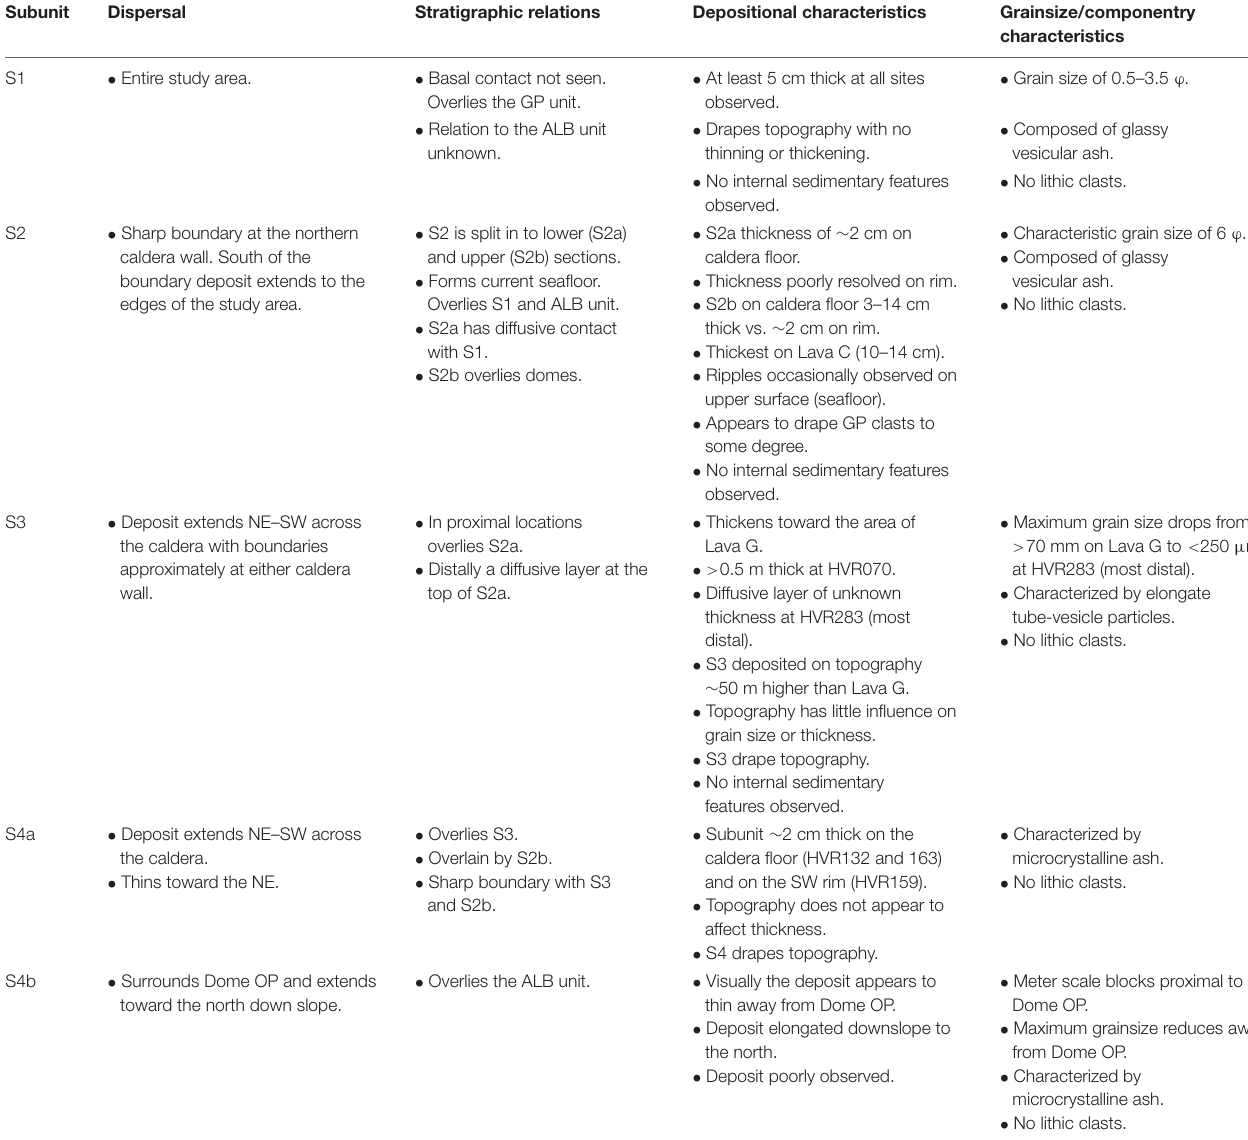
TABLE 1 | Summary table of subunit dispersal, stratigraphic, and depositional characteristics. Subunit